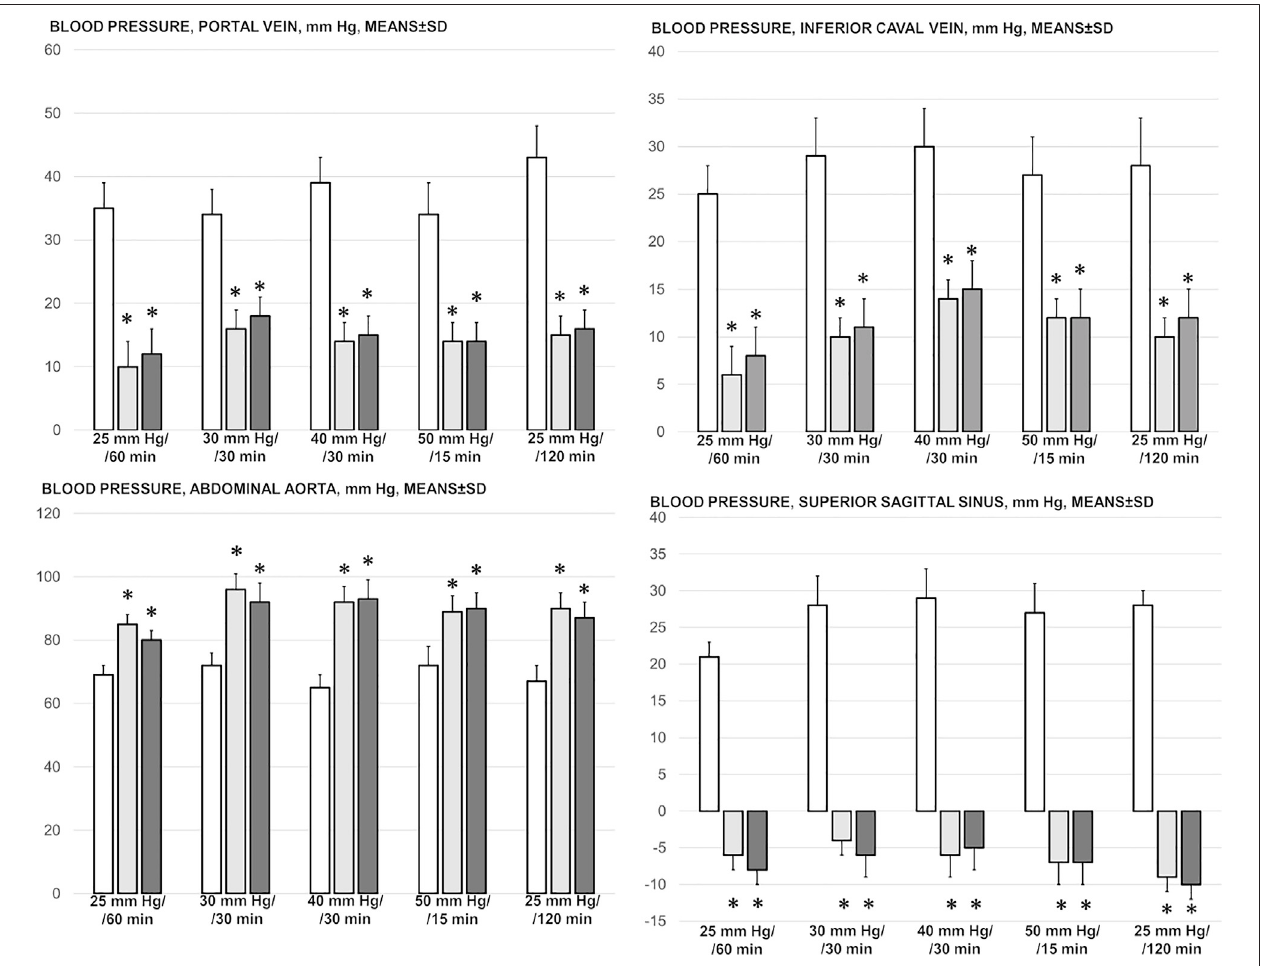
FIGURE 1 | Blood pressure, mmHg (in the superior sagittal sinus (SSS), portal vein (PV), abdominal aorta (AA), inferior caval vein (ICV)), in the thiopental- anesthetized rats with the increased intra-abdominal pressures at 50 mmHg for 25 min, at 30 mmHg or 40 mmHg for 30 min, and at 25 mmHg for 60 min increased intra-abdominal pressures-time, and in the esketamine-anesthetized rats with the increased intra-abdominal pressures at the 25 mmHg for 120 min increased intra- abdominalpressures-time,followingmedication(BPC15710 μ g/kg(lightgraybars),10 ng/kg(darkgraybars);saline5 ml/kg(whitebars))givensubcutaneouslyat 10 min increased intra-abdominal pressures-time. Means ± SD, *P ˂ 0.05, vs.